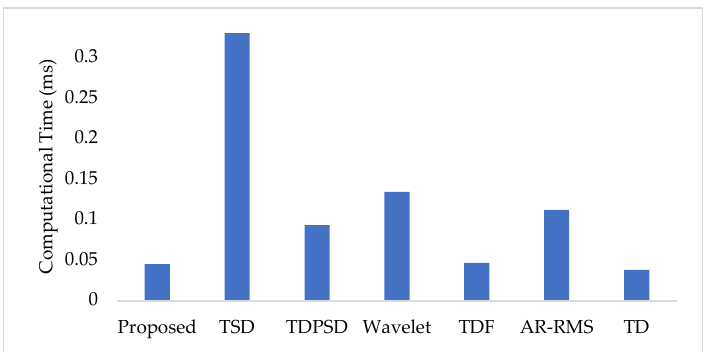
Figure 11. The feature extraction time for different feature extraction methods.